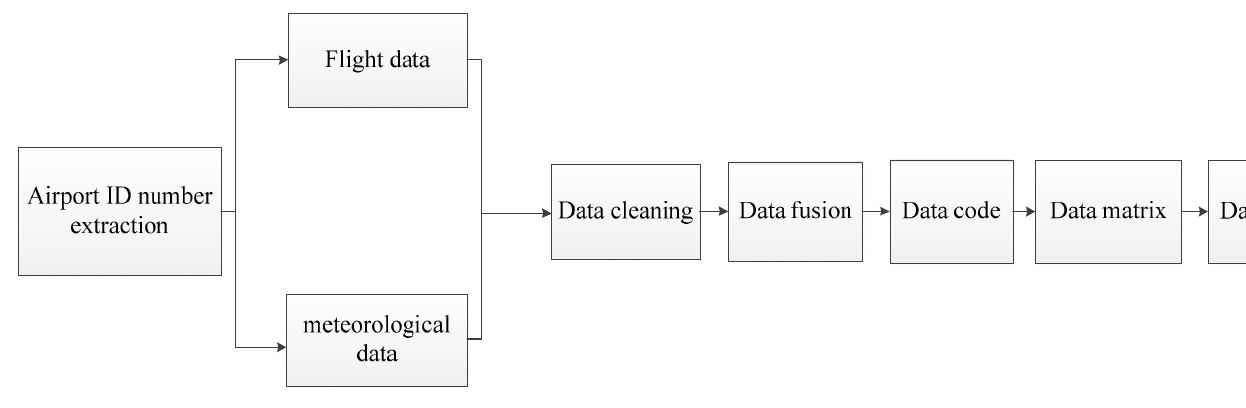
Figure 4. Data processing flowchart.